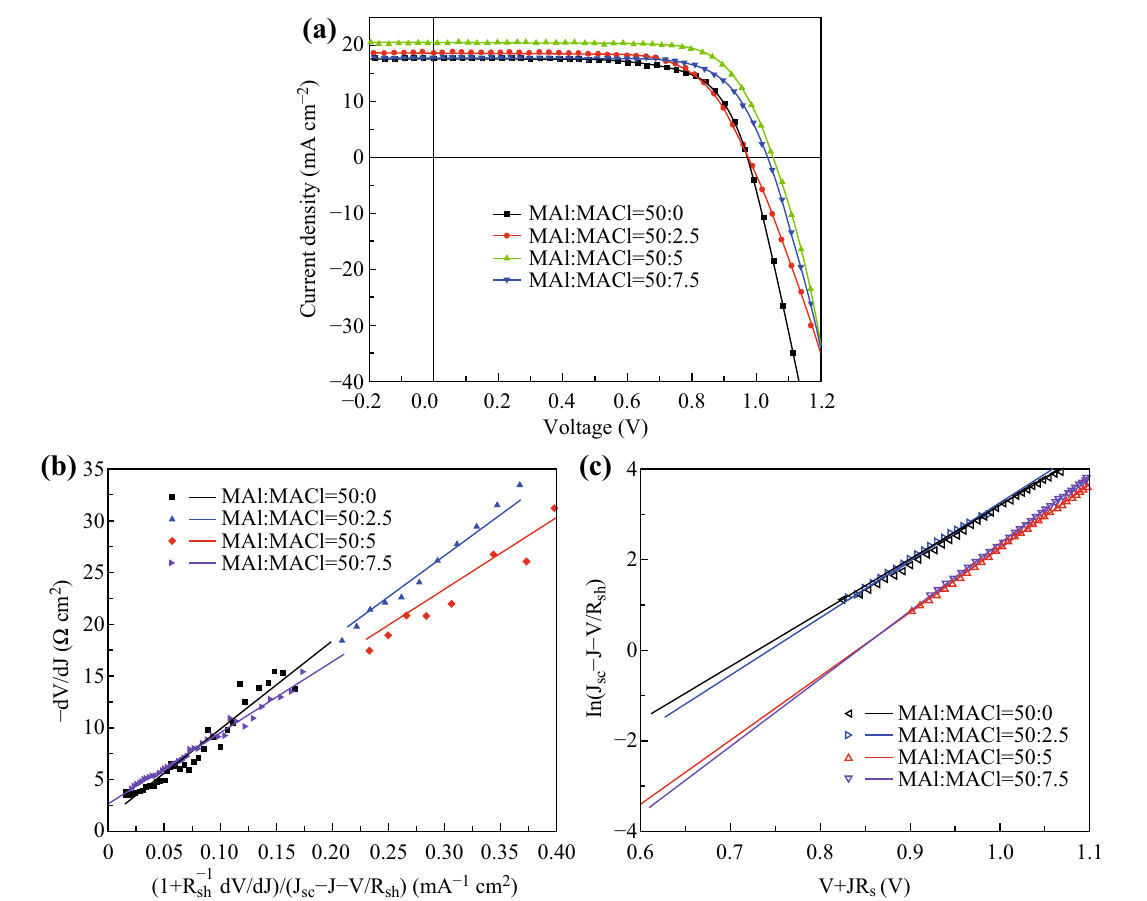
Fig. 3 a Current–voltage curve for planar perovskite solar cells using TiO 2 /CH 3 NH 3 PbI 3-x Cl x /Spiro-OMeTAD/Au architecture, the perovskite films prepared by mixing with different concentrations of Cl ions. The measurements are carried out under 100 mW cm - 2 . b Plots of (cid:7) (symbols) and the linear fitted curve (solid lines). c Plots of ln( J sc - J - V / R sh ) versus V ? JR s (symbols) and (cid:3) d V = d J versus the linear fitted curve (solid lines). (Color figure